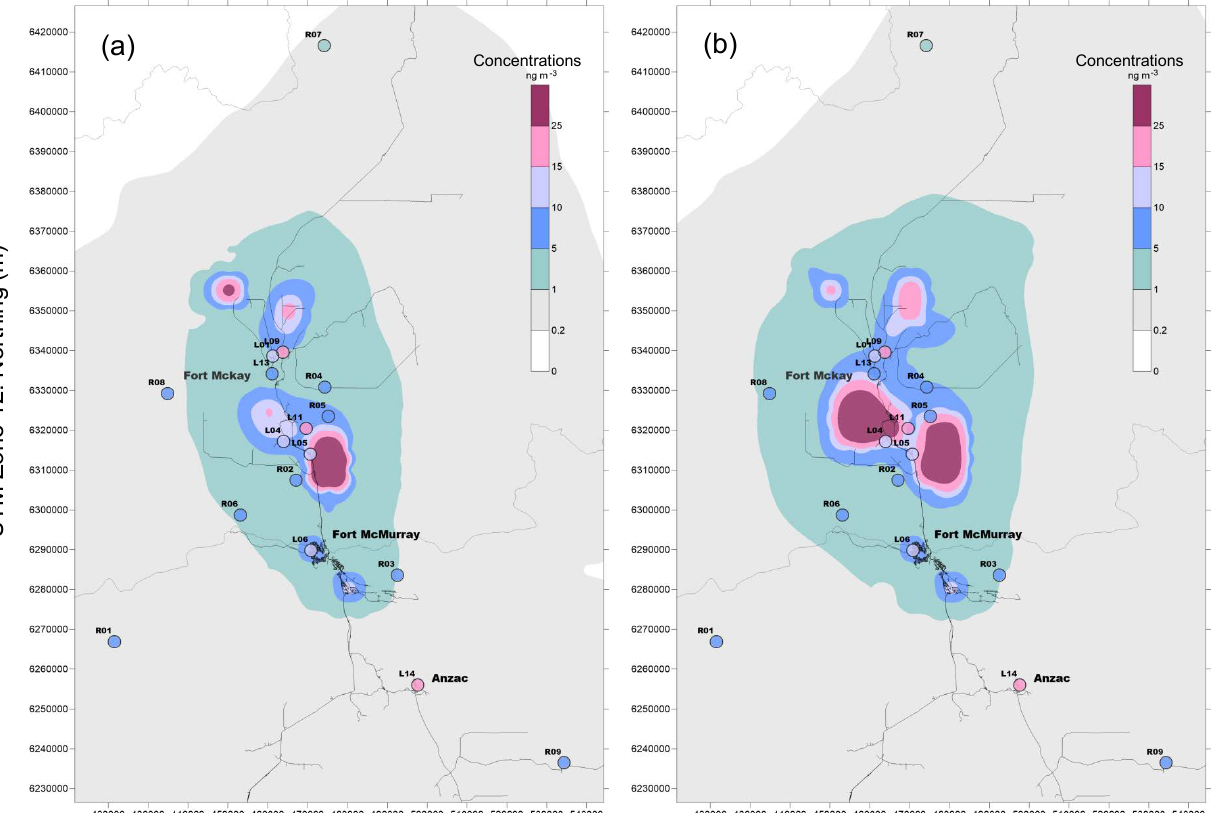
Figure 2. Average model-predicted PAH concentration contours using CEMA-derived emissions (a) and JOSM-derived emissions (b) over- laid with passive measurements (circles) from November 2010 to June